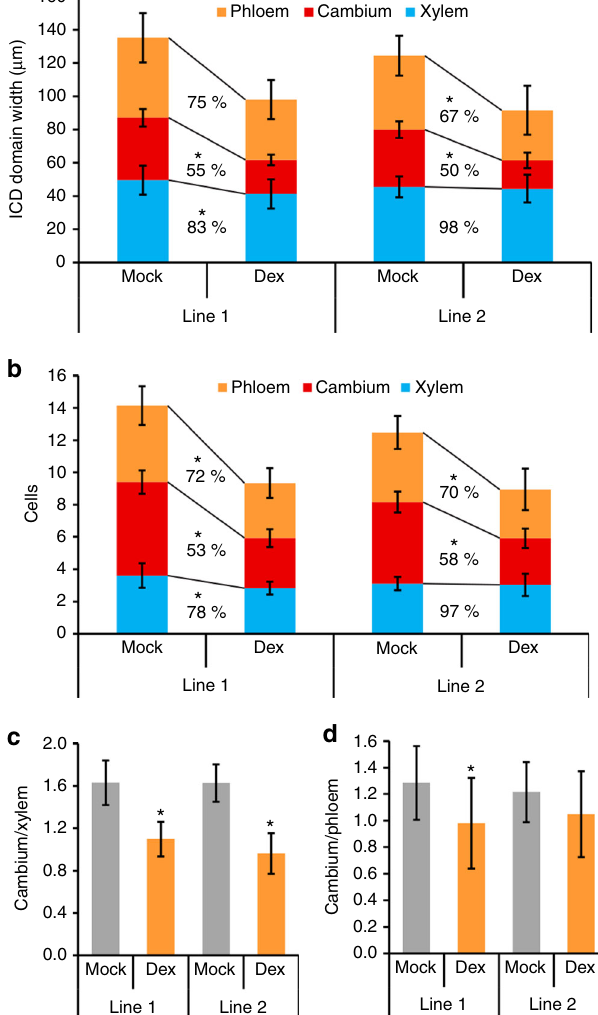
Fig. 7 ARF5 predominantly affects the cambium-to-xylem ratio. a Quanti fi cation of the width of the vascular tissues phloem (orange), cambium (red) and xylem (blue) and the ICD at the stem base of two mock and Dex-treated pPXY:GR-ARF5 Δ III/IV lines. Student ’ s T -test was performed comparing mock and Dex-treated plants (line 1: phloem p = 0.063, cambium p = 6.8E-08, xylem p = 0.49; line 2: phloem p = 0.036, cambium p = 1.28E-06, xylem p = 0.76, sample size n = 8 – 10). Error bars represent ±standard deviation. Signi fi cance is indicated by the asterisk. b Quanti fi cation of cell numbers in interfascicular regions. Student ’ s T -test was performed comparing two mock and Dex-treated pPXY:GR-ARF5 Δ III/ IV lines (line 1: phloem p = 0.013, cambium p = 1.98E-08, xylem p = 0.012; line 2: phloem p = 0.03, cambium p = 1.54E-06, xylem p = 0.79, sample size n = 8 – 10). Error bars represent ±standard deviation.